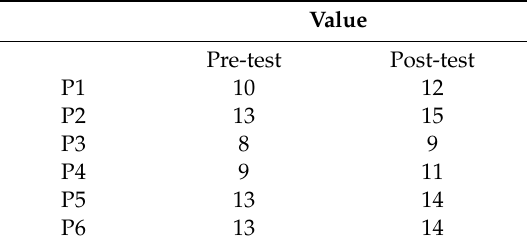
Table 8. Grouped pre-test / post-test results of the self-motivation test: Do you have enough self-confidence?